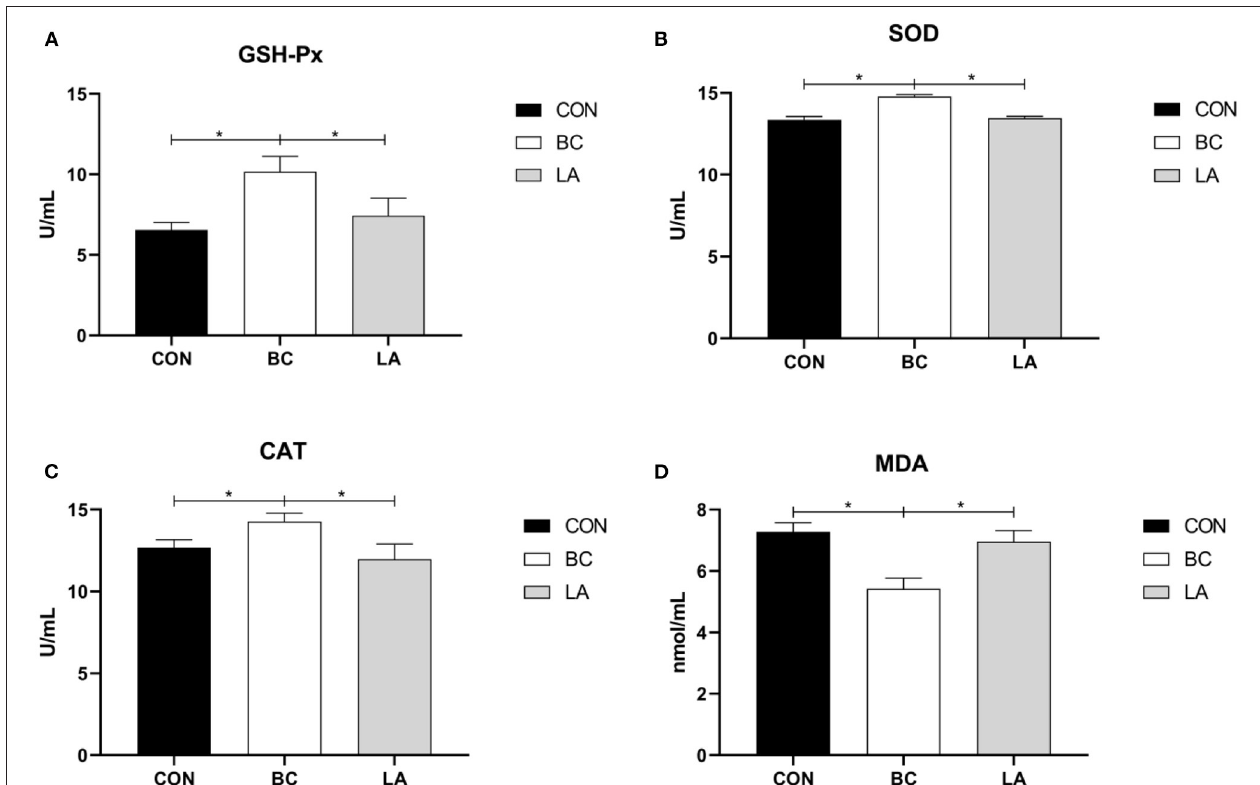
FIGURE 7 | (A–D) Effects of probiotics on serum antioxidant enzyme activity induced by lipopolysaccharide in broilers. CON, broilers were not treated except for the base diet; BC, broilers were supplemented with Bacillus coagulans ; LA, broilers were supplemented with Lactobacillus plantarum ; “ * ” means significantly difference. N =